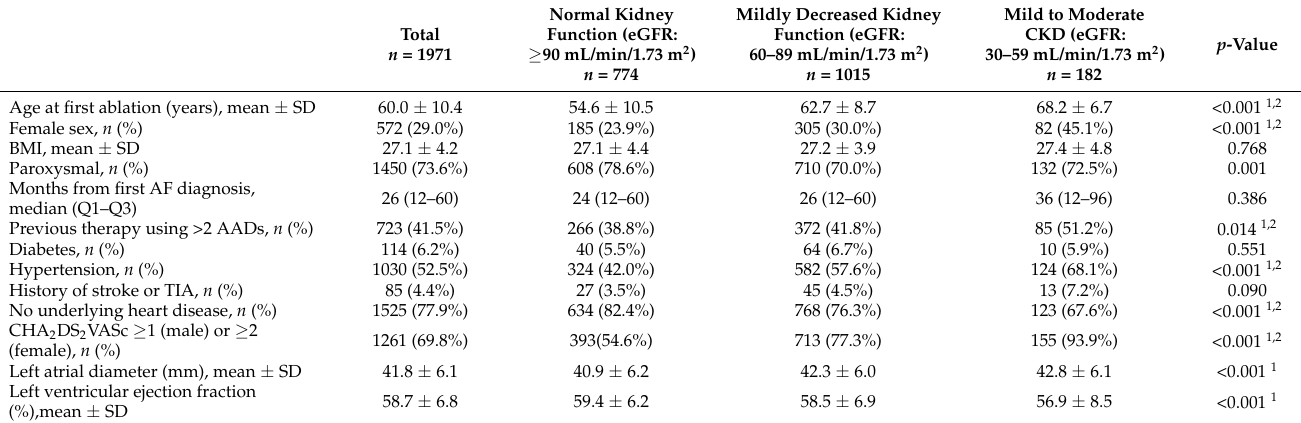
Table 1. Baseline